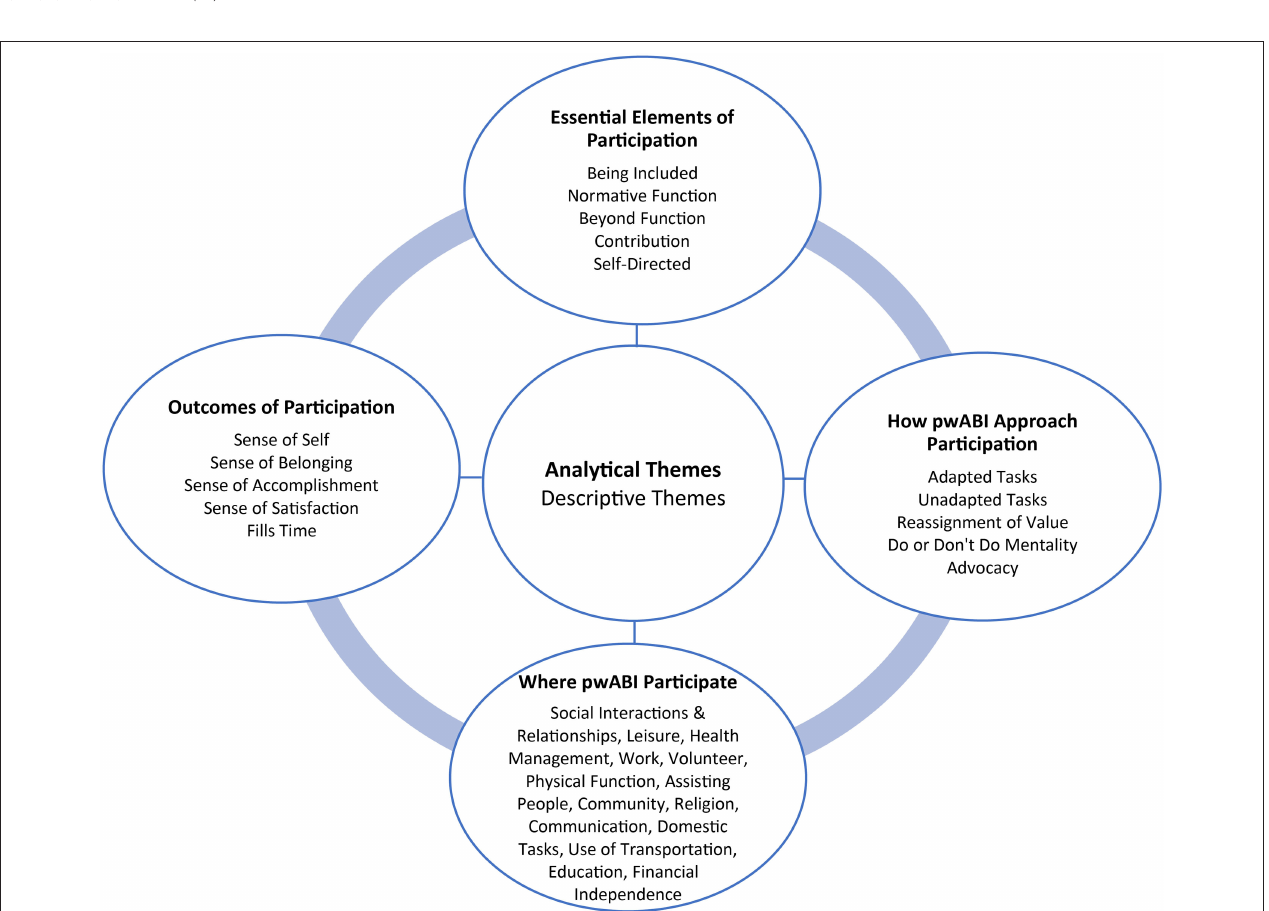
FIGURE 2 | Analytical and descriptive